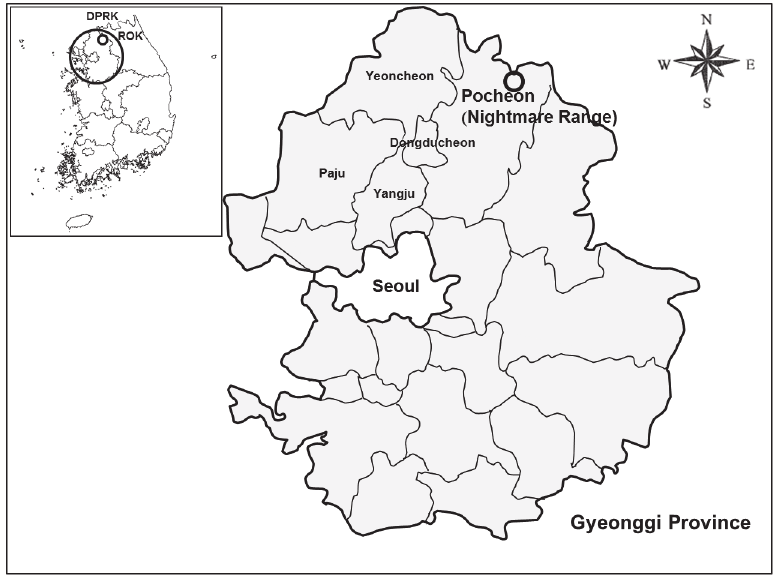
Fig 1. Nightmare Range, Gyeonggi Province, where rodent-borne disease surveillance was conducted monthly from January 2008-December 2009.